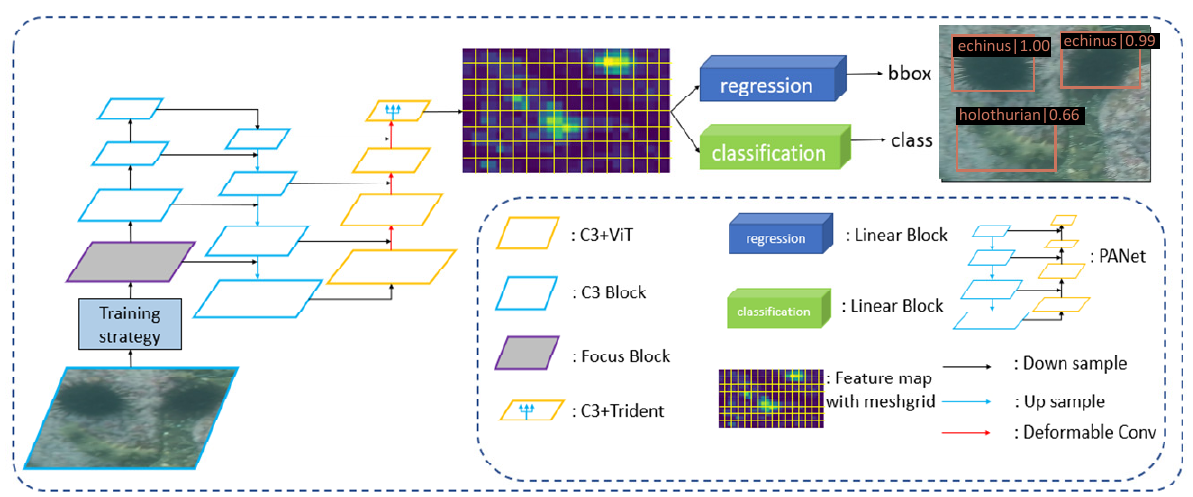
Figure 2. The neural network structure of the proposed framework.